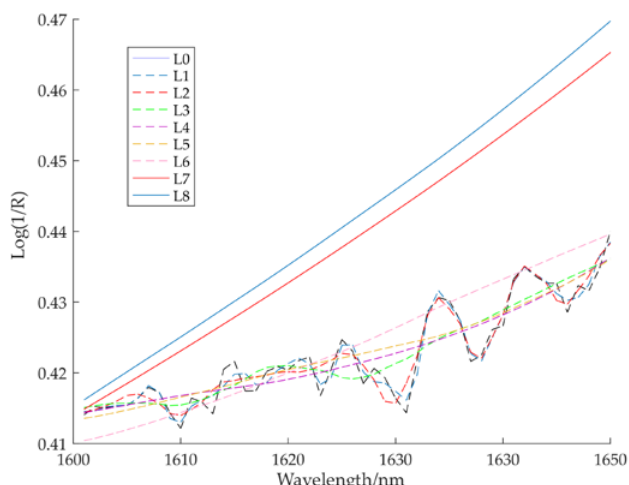
Figure 4. Zoom in on a noise spectral image around 1700 nm. Note: L0 refers to the original spectrum, L1 refers to the reconstructed spectral average after the layer wavelet transforms, L2 to L8 are analogous to L1. L0–L6 have similar trends under L7 and L8. L7 and L8 correspond to solid red and solid blue, respectively.